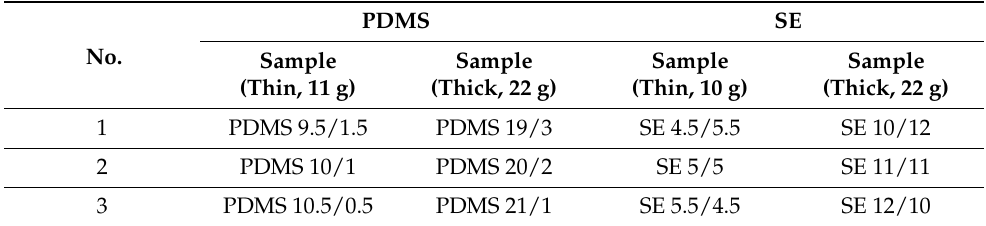
Table 1. Samples with various mixtures of PDMS and Silicone Elastomer (SE). PDMS SE No. Sample Sample Sample Sample (Thin, 11 g) (Thick, 22 g) (Thin, 10 g) (Thick, 22 g) 1 PDMS 9.5/1.5 PDMS 19/3 SE 4.5/5.5 SE 10/12 PDMS 10/1 PDMS